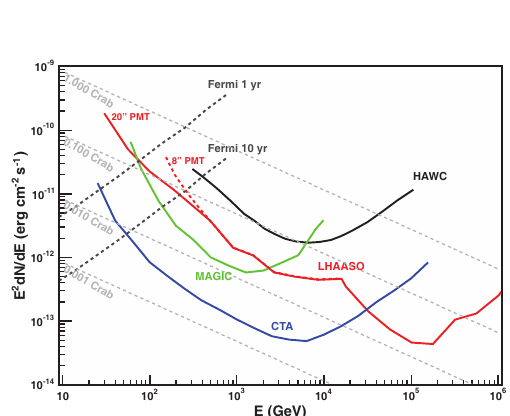
(cid:19)(cid:10) (cid:2) (cid:20)(cid:21)(cid:22) (cid:3)